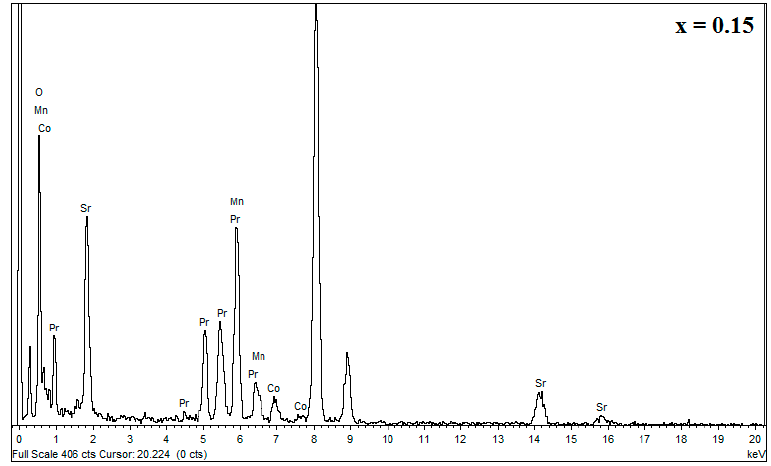
Figure 6. EDS spectrum showing the different chemical elements in the Pr 0.7 Sr 0.3 Mn 0.85 Co 0.15 O 3 . Table 4. EDS chemical analysis for Pr 0.7 Sr 0.3 Mn 0.85 Co 0.15 O 3 sample. Sample